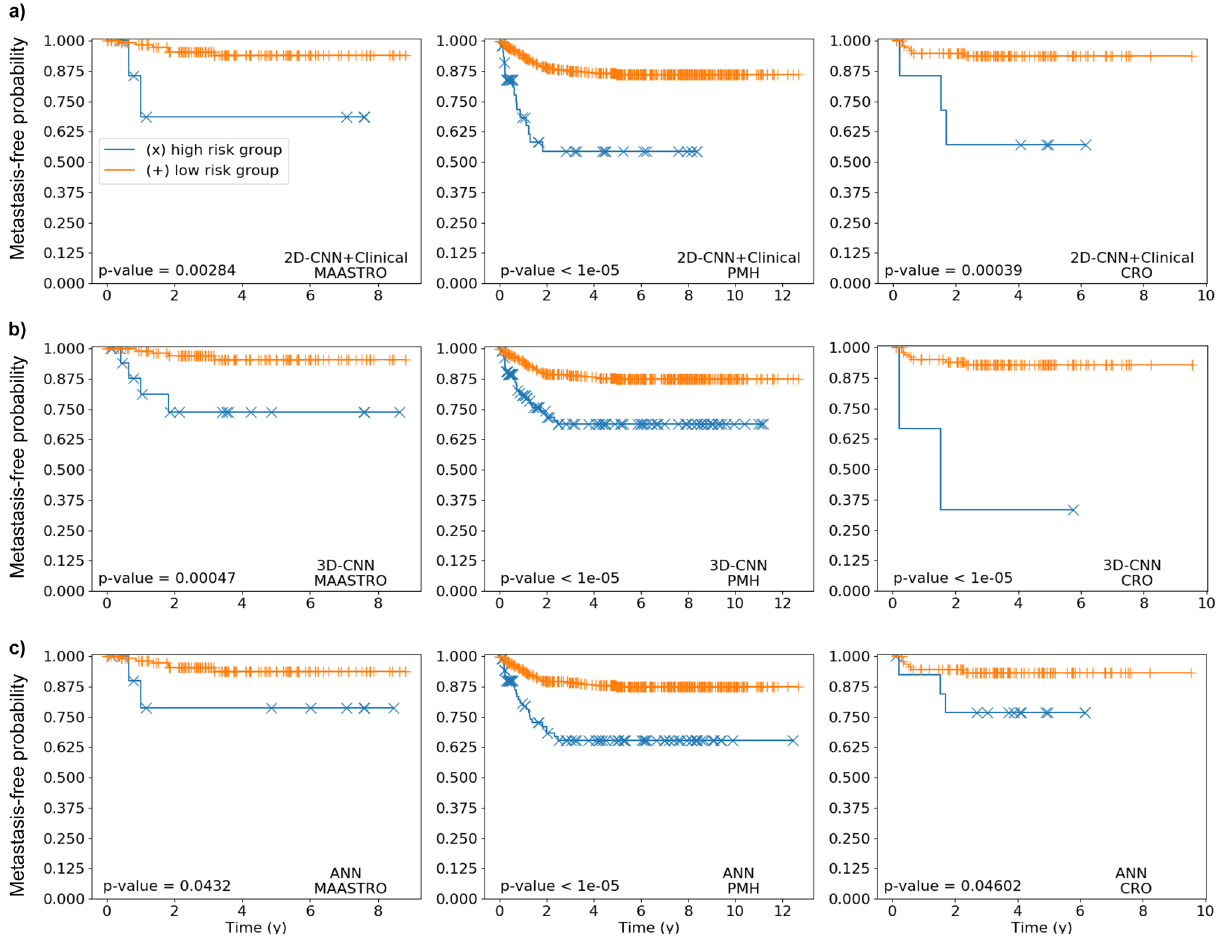
Figure 3. Kaplan–Meier curves obtained when applying time-to-event models on the 3 testing cohorts. The testing patients were stratified into two groups by using an optimised threshold obtained during CV. The displayed p values were computed using the log rank test. ( a ) Kaplan–Meier curves resulting from 2D-CNN+Clinical. ( b ) Kaplan–Meier curves resulting from 3D-CNN. ( c ) Kaplan–Meier curves resulting from ANN based on clinical